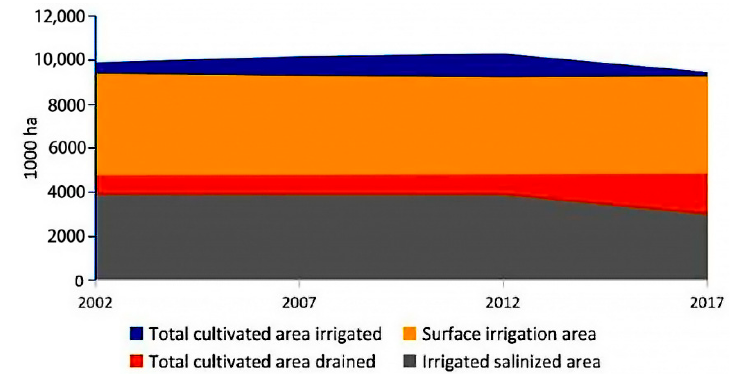
Figure 3. Change of land management in Central Asia.